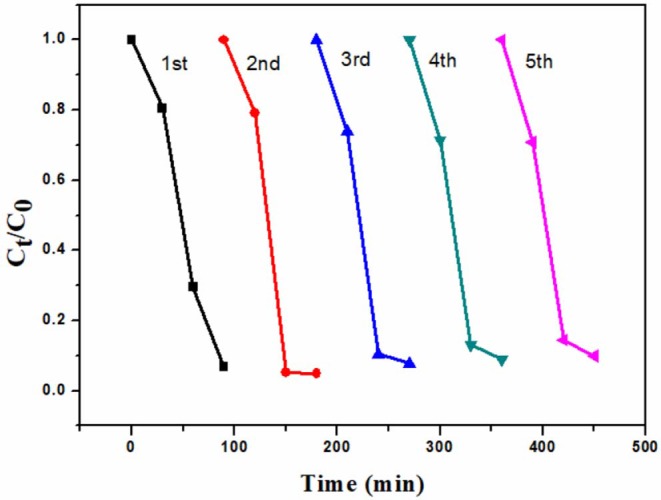
The reusability of 6B-TiO2.